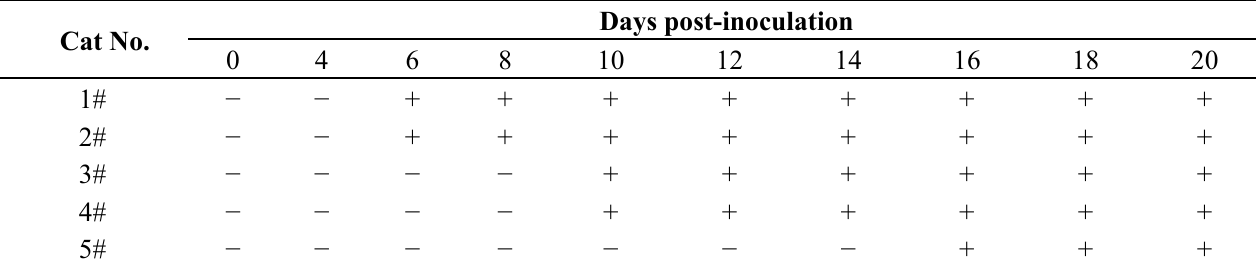
Table 1. Results of viral DNA detected in samples collected from cats. A minus sign was used to represent negative PCR results, and a plus sign was used for positive results. The samples were collected on even